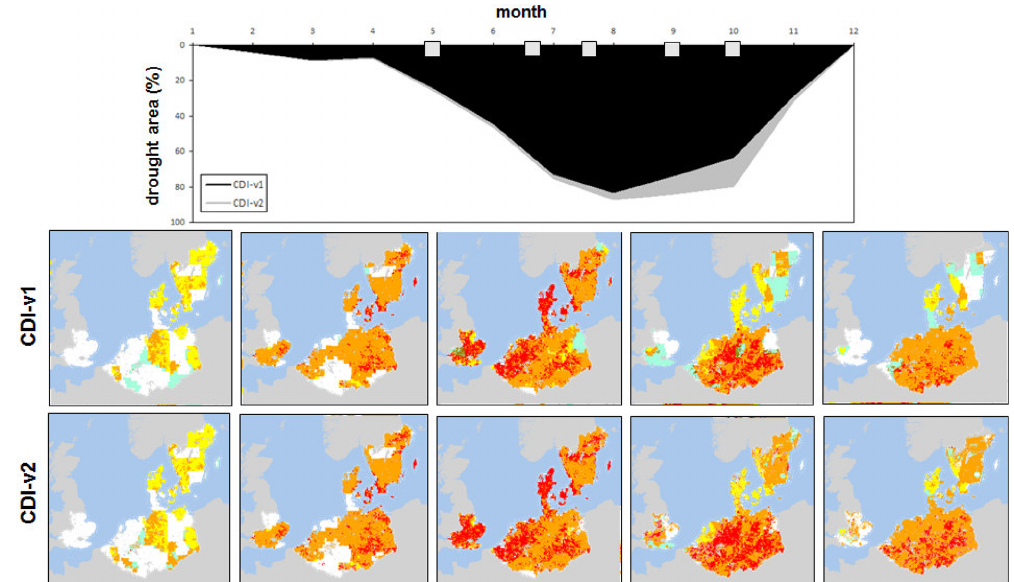
Figure 9. Temporal evolution of the 2018 northern European drought according to the two versions of the CDI. The upper plot shows the percentage of the area under drought (WATCH + WARNING + ALERT, in black for CDI-v1 and in grey for CDI-v2), whereas the lower images depict the spatial distribution of CDI-v1 (upper row) and CDI-v2 (lower row) for the selected dekads (demarked in the upper plot by the squares on the x